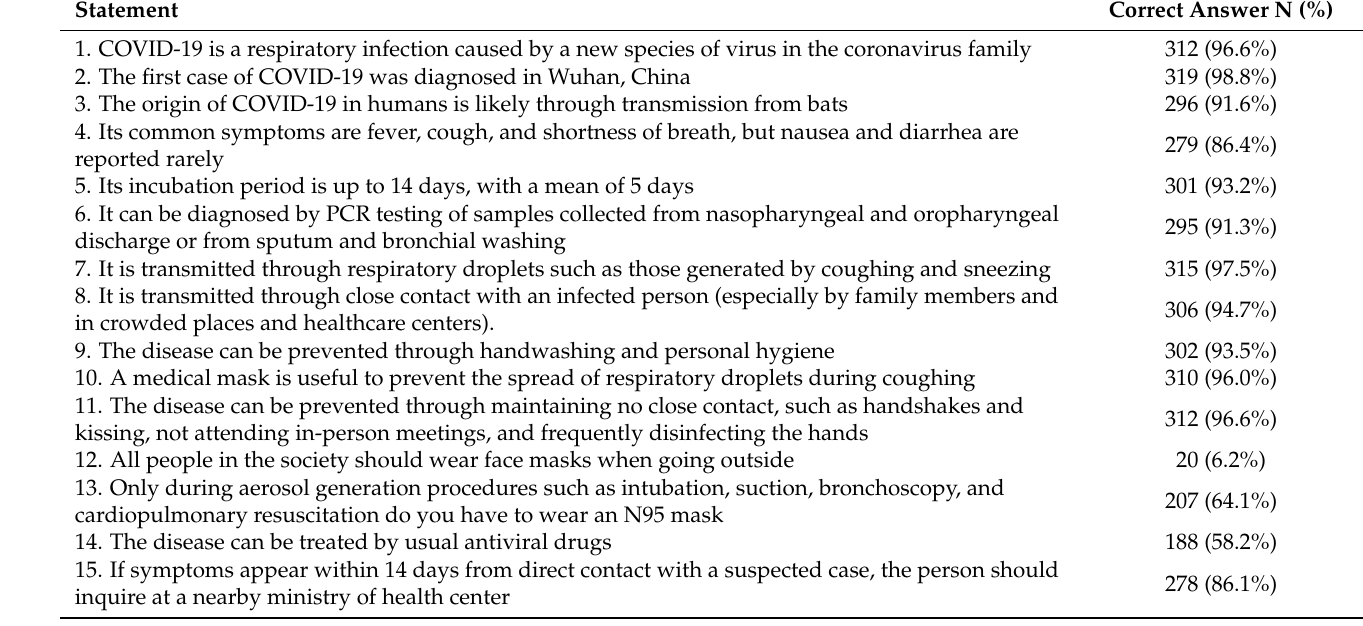
Table 2. Assessment of medical students’ knowledge regarding COVID-19 ( n = 323).